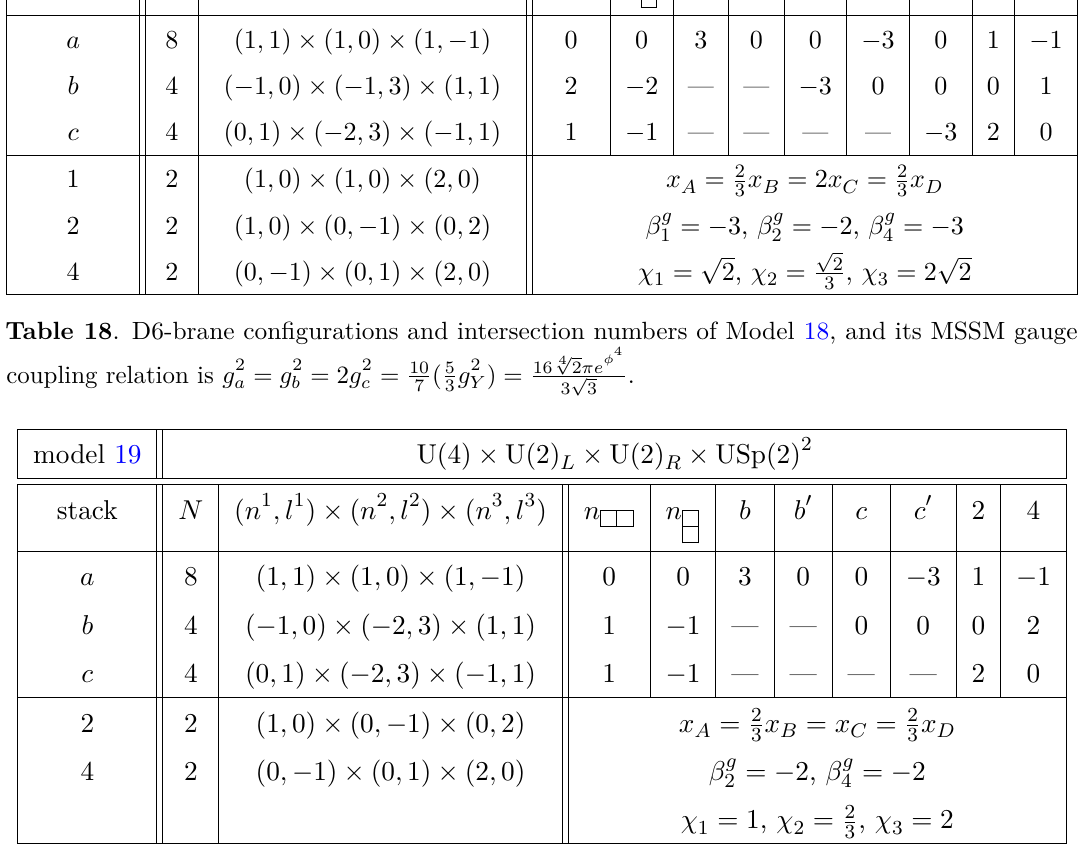
Table 19 . D6-brane configurations and intersection numbers of Model 19, and its MSSM gauge